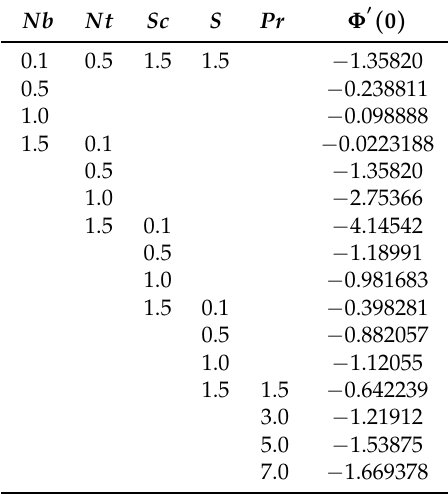
Table 3. Variation in Sherwood number with different values of the parameters Nb , Nt , Sc , S and Pr . Nb